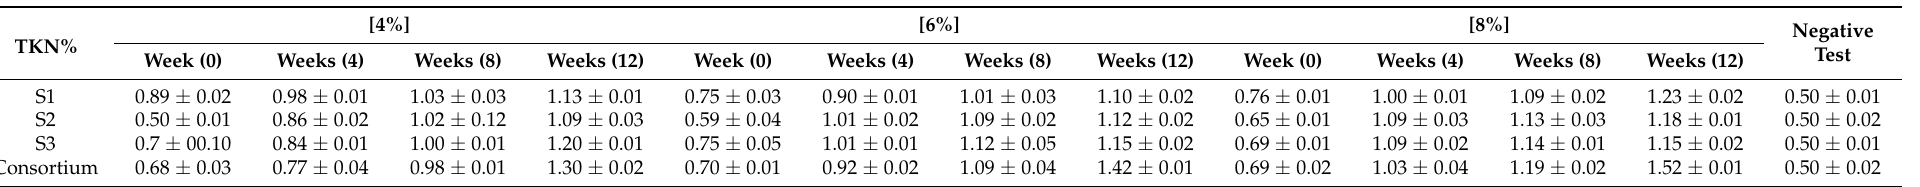
Table 3. Evolution of TKN degradation of the three strains isolated (Strain 1; S2: Strain 2; S3: Strain 3) and their consortium as function of the time at different inoculum doses (4%, 6%, and 8%).